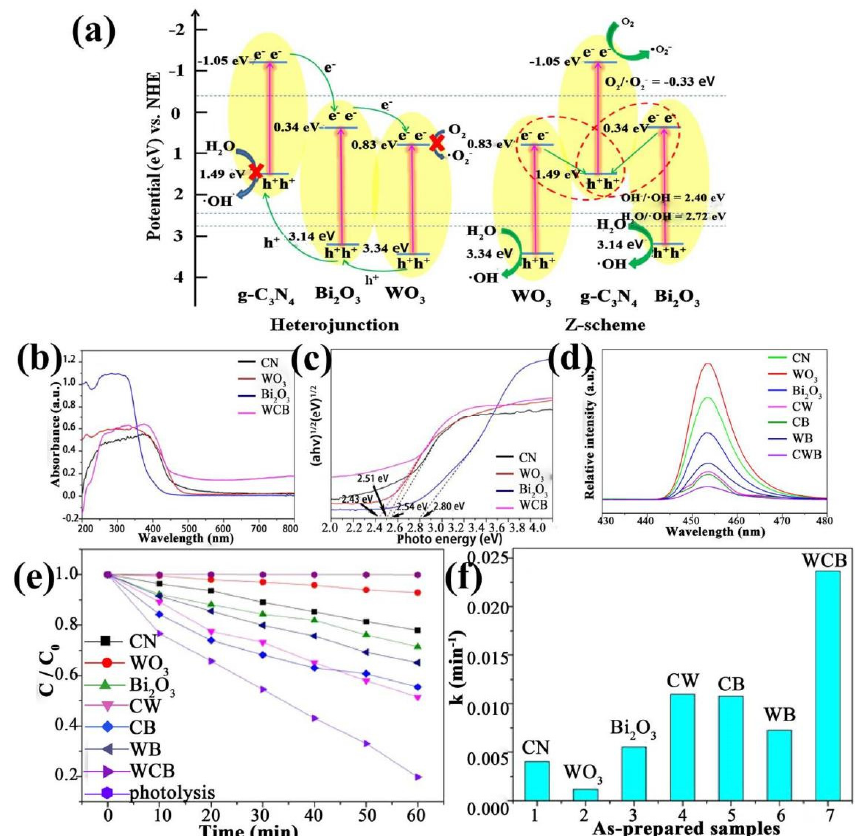
Figure 9. ( a ) Schematic diagram of charge separation in WO 3 /g − C 3 N 4 /Bi 2 O 3 , ( b ) UV-vis spectra, ( c ) band gap, ( d ) photoluminescence spectra, ( e ) photocatalytic activities for TC degradation under visible − light and ( f ) apparent rate constants for TC degradation obtained from the various samples. Used with permission from [136]. Copyright 2018 Elsevier.